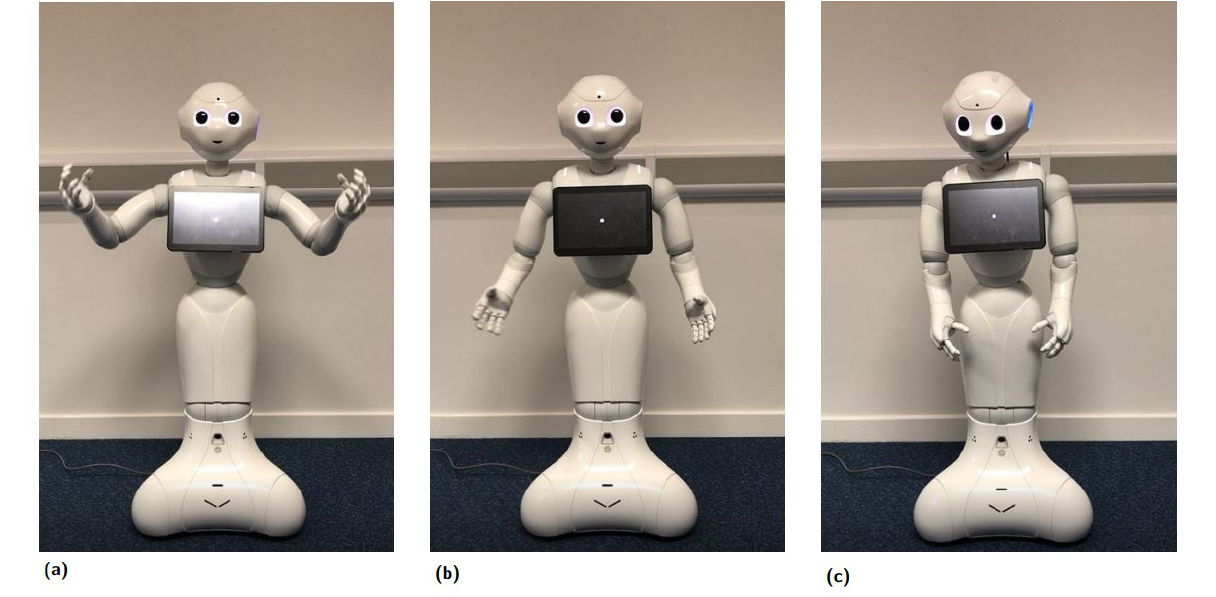
Figure 1: Example snippets of happy (a), neutral (b) and sad (c) robot